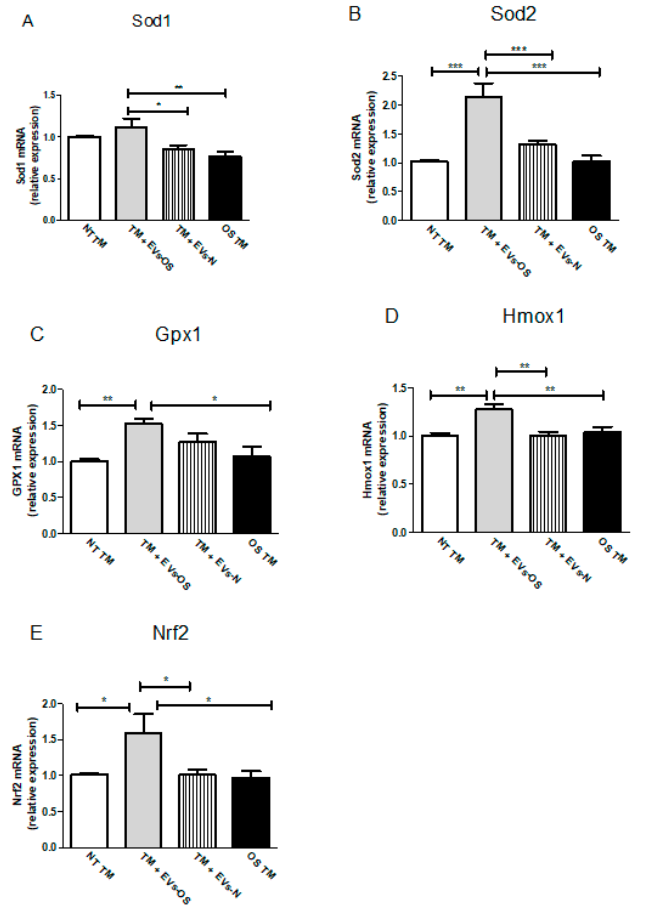
Figure 7. Assessment of oxidative stress-related genes in TM cells. Total RNA was isolated from untreated TM cells or TM cells treated for 1.5 h with 15 mM AAPH, or TM co-incubated with either stressed or normal NPCE EVs, and quantitative real-time PCR was performed to measure the level of Sod1, Sod2, Gpx1, Hmox1, and Nrf2. The results were normalized to 18sRNA. Bars represent mean ± SEM of three independent experiments, where * p < 0.05, ** p < 0.01, *** p < 0.001 in one-way ANOVA with post hoc Tukey’s test.